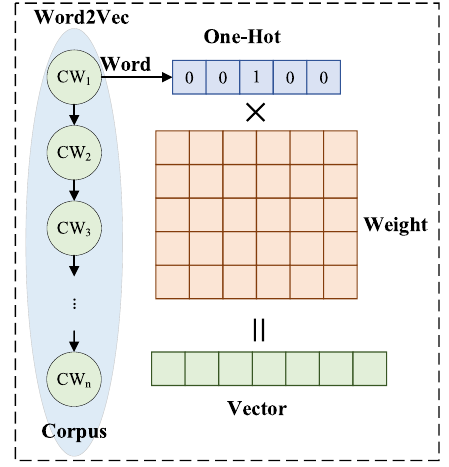
Fig. 3 The flow of Word2vec embedding